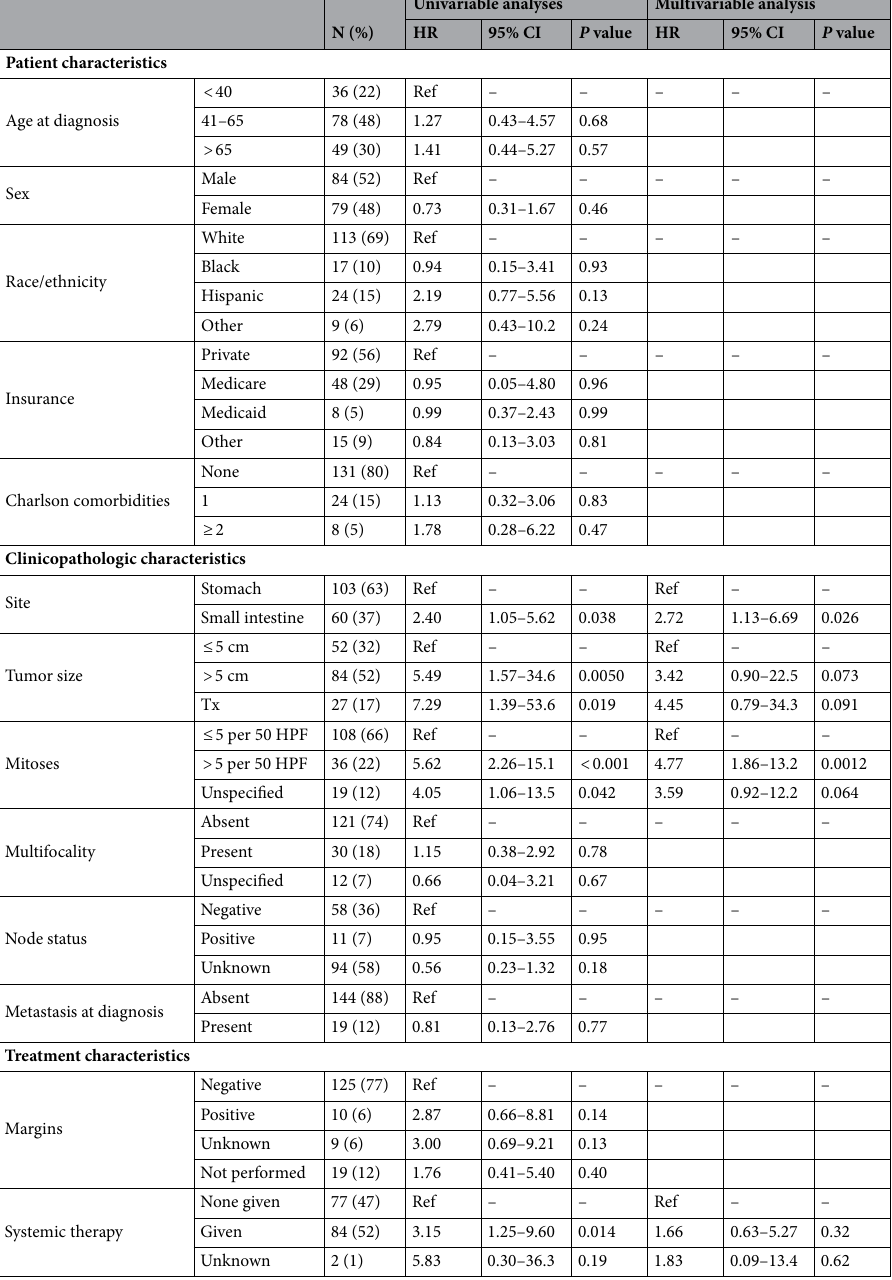
Table 2. Univariable and multivariable Cox proportional hazards analyses of patient demographic, clinicopathologic, and treatment factors, with overall survival AS outcome. HPF high-power field, OR odds ratio, CI confidence